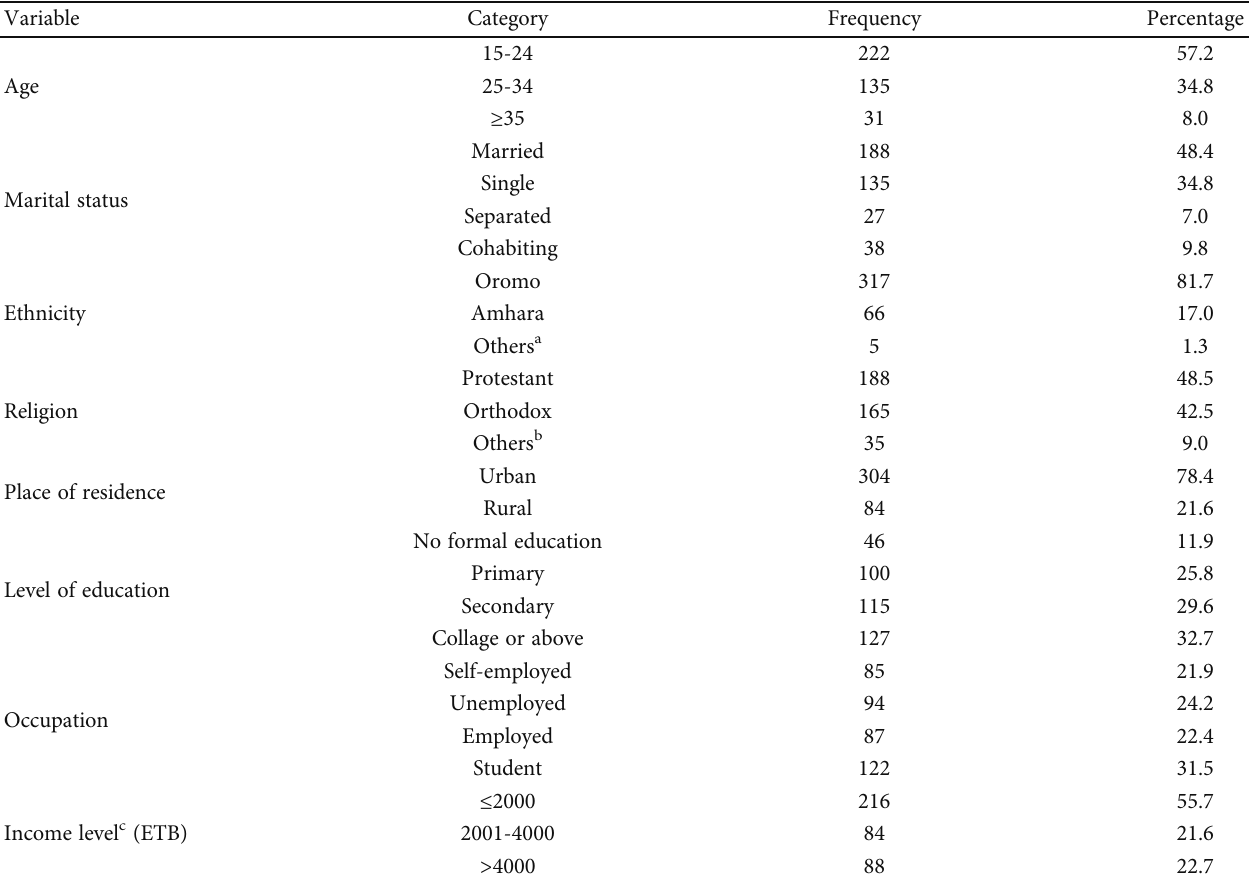
Table 1: The sociodemographic characteristics of women who received abortion care services at health facilities in Ambo town, Oromia region, Ethiopia,